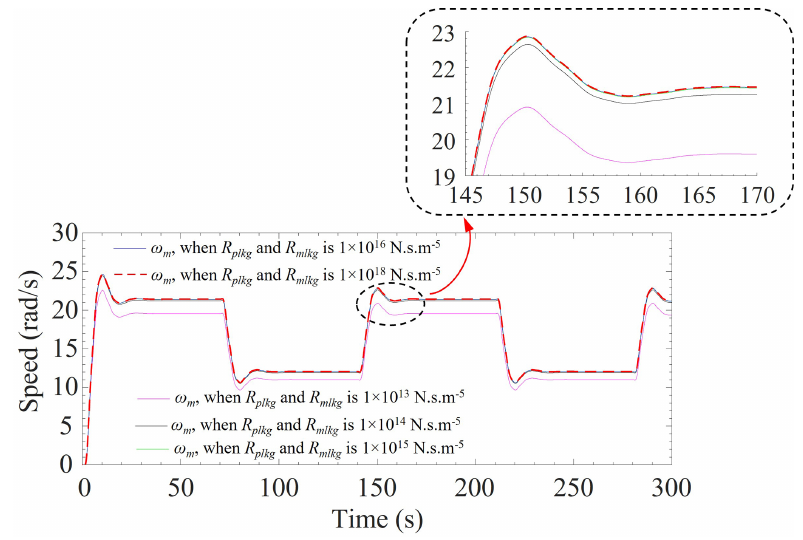
Figure 8. Influence of motor speed due to the variation of leakage resistance.